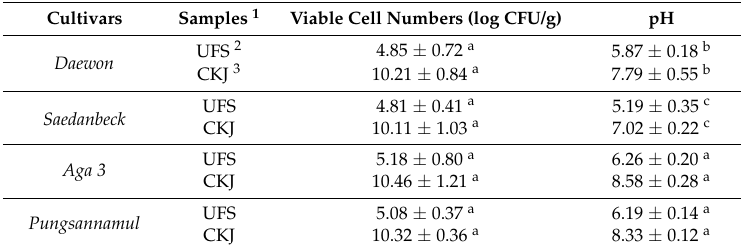
Table 1. Viable cell number and pH of unfermented soybeans and cheonggukjang fermented by Bacillus subtilis (KCTC 13241).